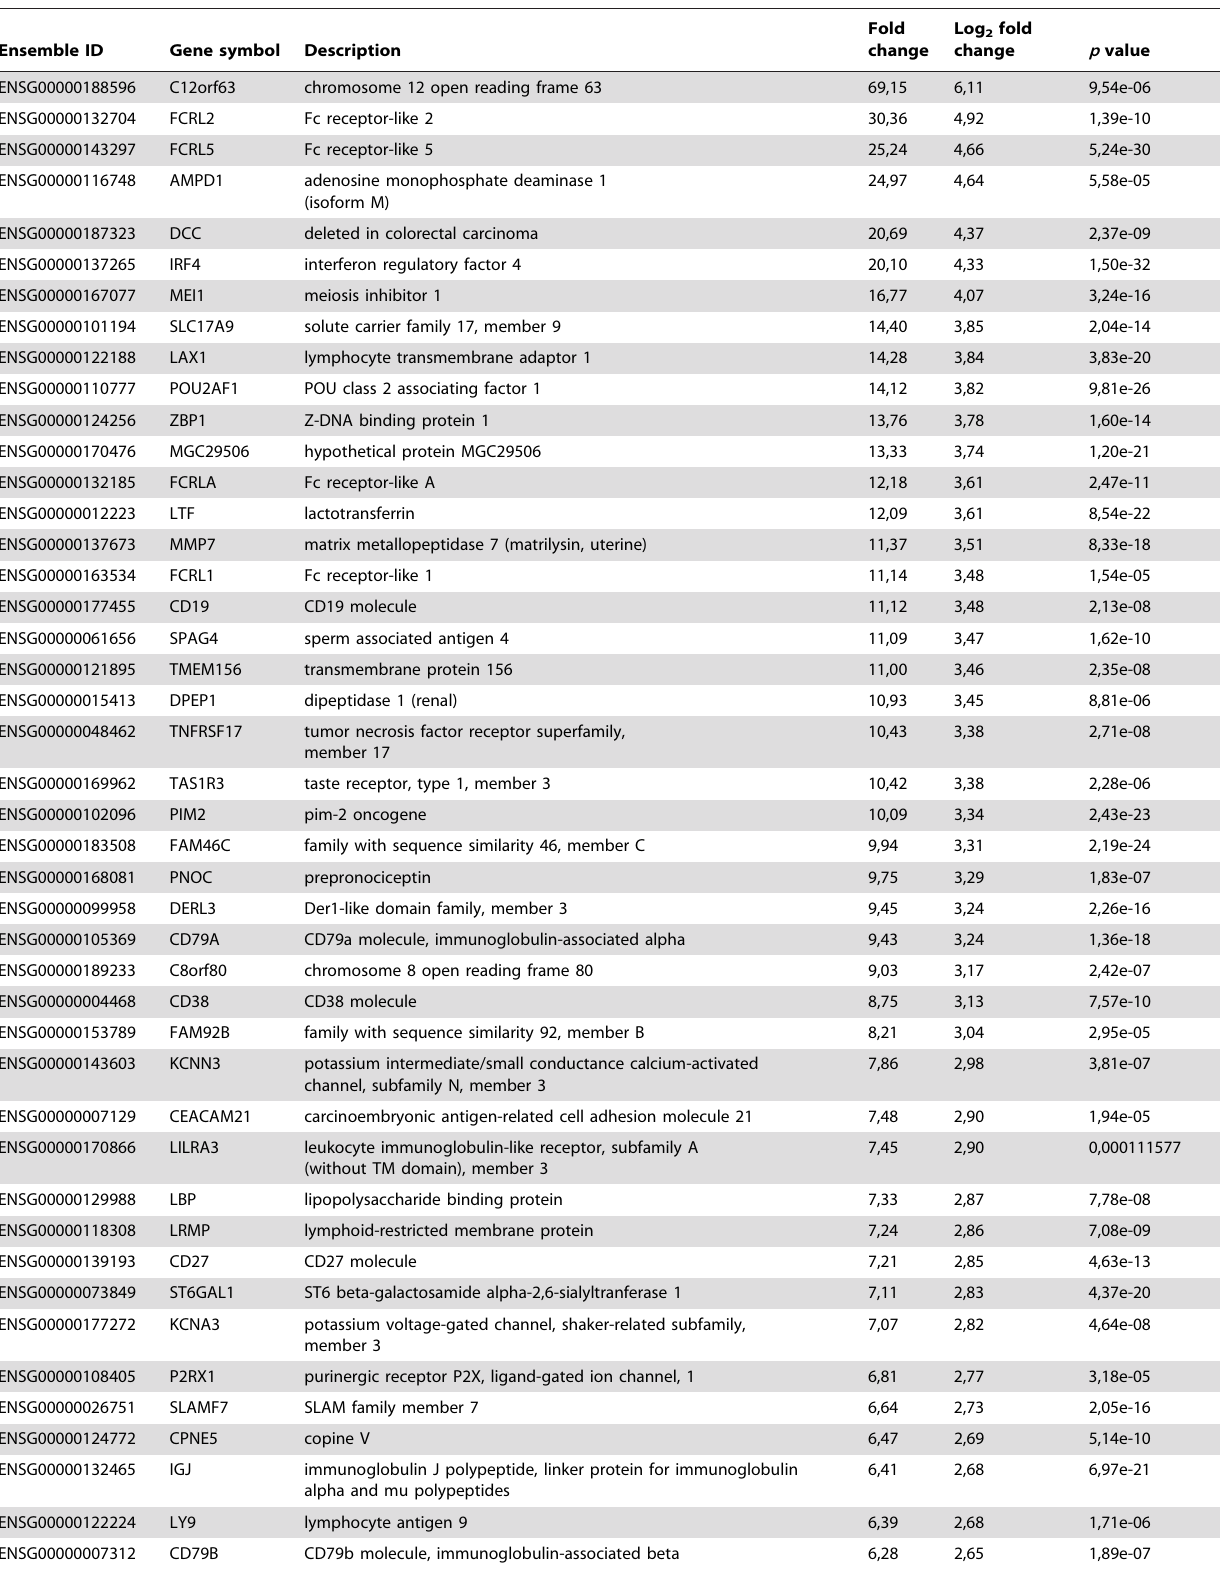
Table 4. Top 50 upregulated genes in periodontitis-affected tissue with Unigene